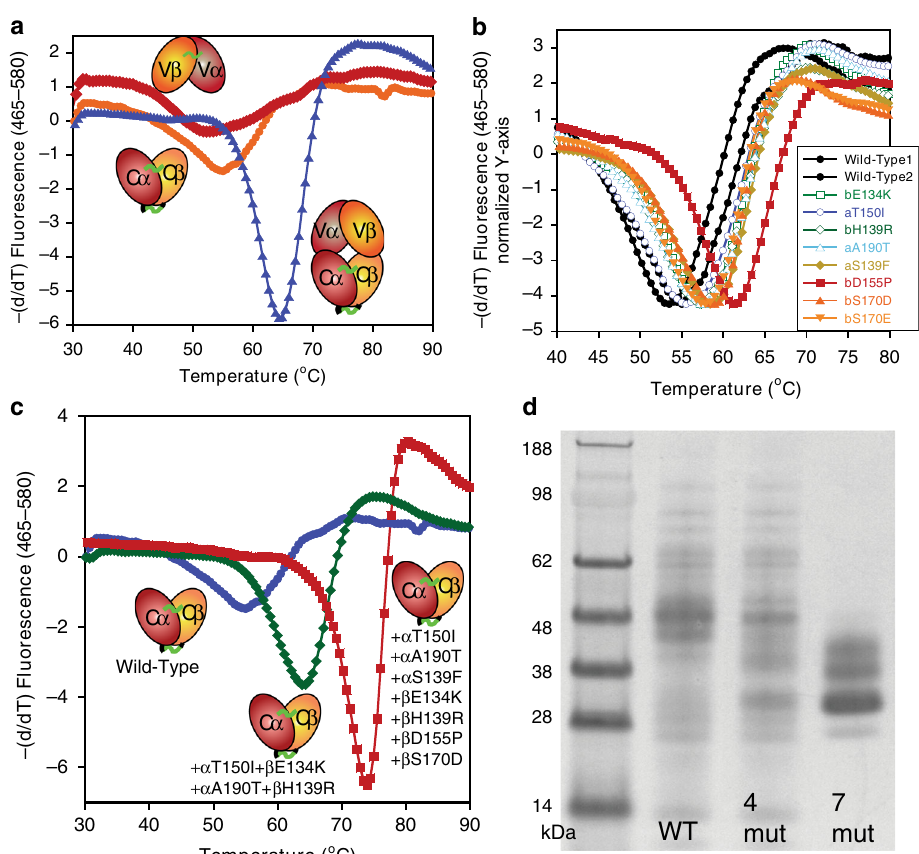
Fig. 1 Characterization of TCR fragments and stabilizing designs. a DSF denaturation curves with recombinant TCR (1G4_122, ▴ ), V α /V β fragment from the same TCR ( ♦ ) with an α 42/ β 110 engineered disul fi de (homologous to the VH44/VL100 disul fi de in dsFvs), and C α /C β fragment with both the standard stalk disul fi de and a stabilizing α 166/ β 173 disul fi de ( ● ). b DSF denaturation curves of the “ wild-type ” (WT) C α /C β subunit and C α /C β subunits containing individual stabilizing mutations. c DSF curves of wild-type C α /C β ( ● ) and C α /C β with 4 ( ♦ ) and 7 ( ■ ) stabilizing mutations. All points on the DSF plots are the single measured fl uorescence values at each temperature. d SDS-PAGE characterization of wild-type C α /C β (left lane) and C α /C β with four (middle lane) and seven (right lane) stabilizing mutations. While this direct comparison by SDS-PAGE was performed once, at least two preparations (>3 for the wild-type C α /C β ) were produced for each protein yielding similar SDS-PAGE results. Source data are available in the Source Data fi